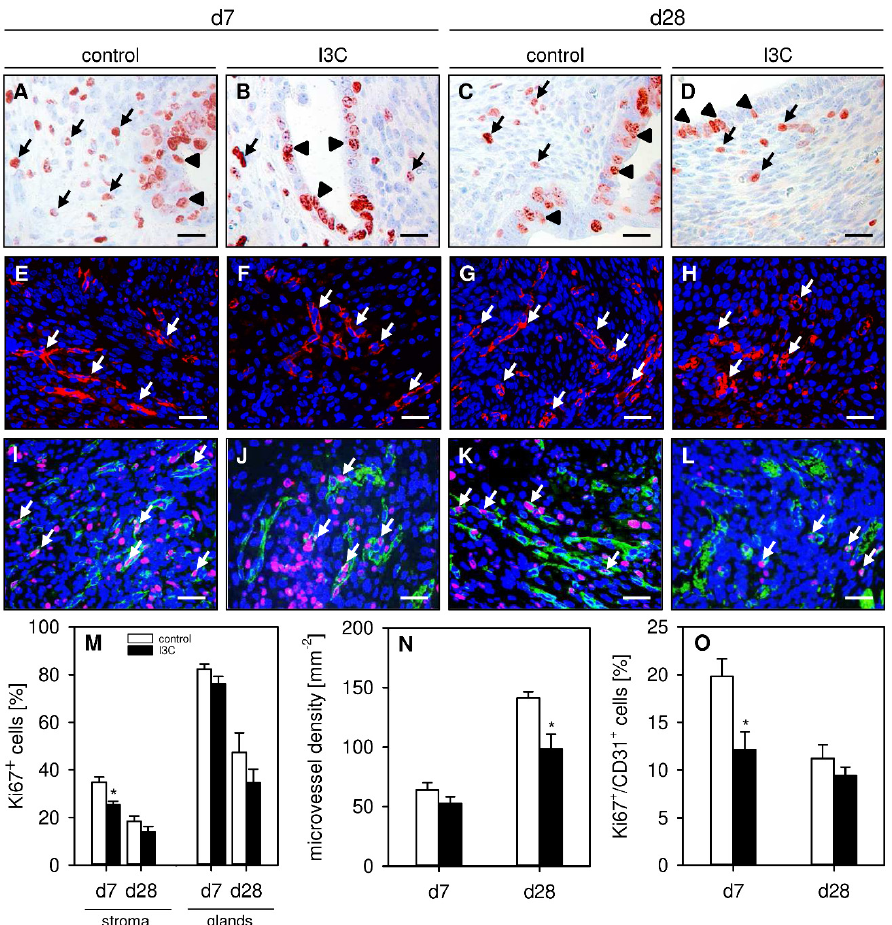
Figure 4. ( A - D ): Immunohistochemical detection of Ki67 + stromal cells (arrows) and glandular epithelial cells (arrowheads) on day 7 ( A , B ) and day 28 ( C , D ) after transplantation of uterine tissue samples to the abdominal wall of vehicle-treated control ( A , C ) and I3C-treated BALB/c mice ( B , D ). Scale bars: 20 µm. E-H: Immunofluorescent detection of microvessels (arrows) on day 7 ( E , F ) and day 28 ( G , H ) after transplantation of uterine tissue samples to the abdominal wall of vehicle-treated control ( E , G ) and I3C-treated BALB/c mice ( F , H ). The immunofluorescent sections were stained with Hoechst 33342 to identify cell nuclei (blue) and an antibody against CD31 for the detection of microvessels (red). Scale bars: 30 µm. I-L: Immunofluorescent detection of Ki67 + /CD31 + endothelial cells (arrows) on day 7 ( I, J ) and day 28 ( K , L ) after transplantation of uterine tissue samples to the abdominal wall of vehicle-treated control ( I , K ) and I3C-treated BALB/c mice ( J , L ). The immunofluorescent sections were stained with Hoechst 33342 to identify cell nuclei (blue), an anti- body against CD31 for the detection of endothelial cells (green) and an antibody against Ki67 for the detection of proliferating cells (red). Scale bars: 30 µm. ( M ): Ki67 + cells (%) within the stroma and the glands of endometriotic lesions in vehicle-treated control (white bars; n = 6 - 8) and I3C-treated BALB/c mice (black bars; n = 6-8). Mean ± SEM. * p < 0.05 vs. control. ( N ): Microvessel density (mm − 2 ) of endometriotic lesions in vehicle-treated control (white bars; n = 6-8) and I3C-treated BALB/c mice (black bars; n = 6-8). Mean ± SEM. * p < 0.05 vs. control. ( O): Ki67 + /CD31 + cells (%) in endometriotic lesions in vehicle-treated control (white bars; n = 6 − 8) and I3C-treated BALB/c mice (black bars; n = 6 − 8). Mean ± SEM. * p < 0.05 vs. control.